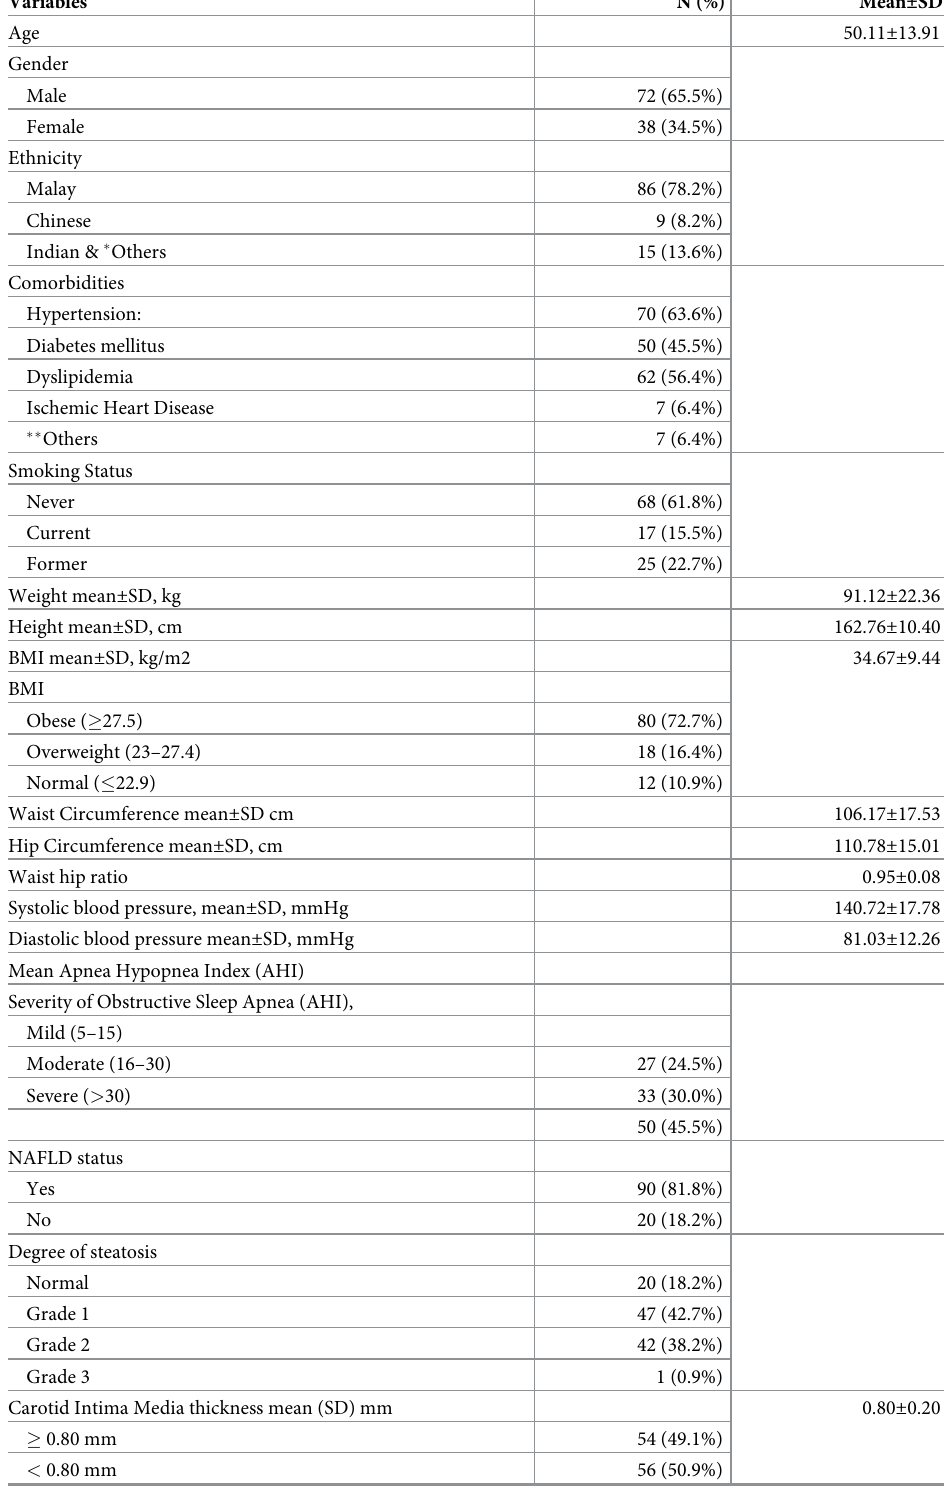
Table 1. Sociodemographic and baseline characteristics of overall study